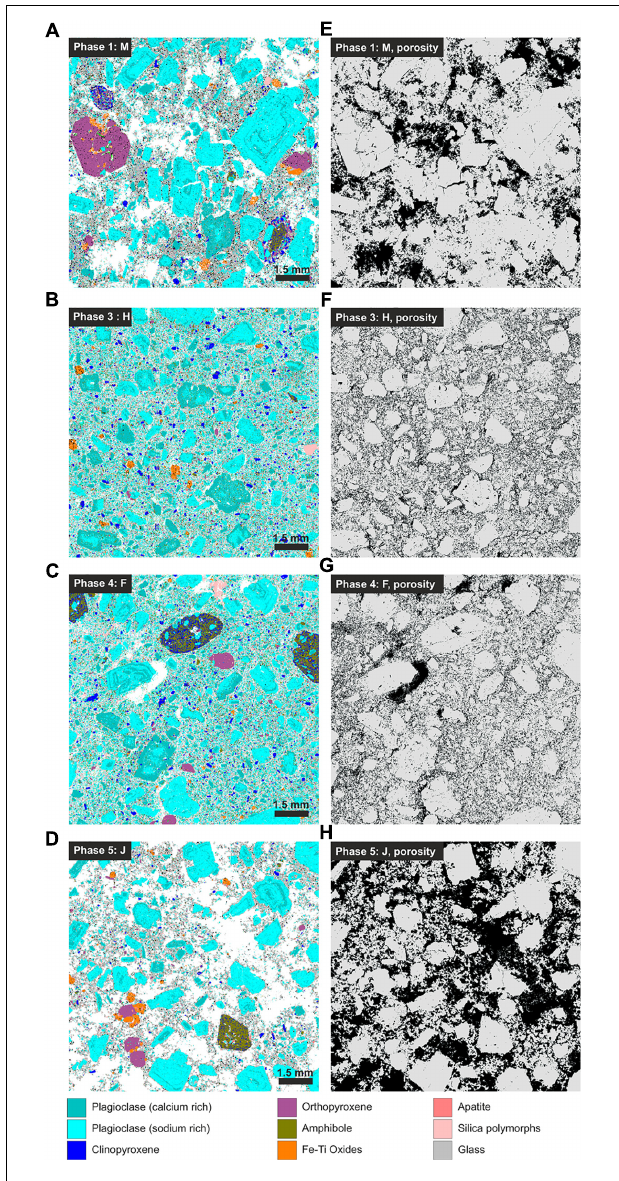
FIGURE 3 | (A–D) QEMSCAN images showing mineral assemblage in one sample from each phase (other samples provided in Supplementary Figure S2 ) – the mineralogical key is shown below the images, with white used to portray the pore space. See Table 2 for full mineral phase analysis; (E–H) pore distribution in one sample from each phase (other samples provided in Supplementary Figure S2 ) using processed QEMSCAN images with solid fraction shown in gray, and all porosity in black. Samples from Phases 3 and 4 are denser, with evenly distributed pore-space, whereas samples from Phases 1 and 5 have higher pore content and show pore-localization and a high connectivity. Backscattered electron images for the same samples are shown in Supplementary Figure S3